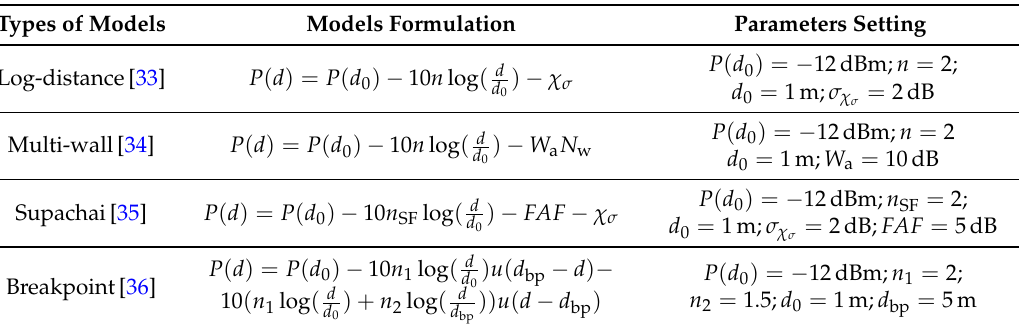
Table 1. Parameters in different signal propagation